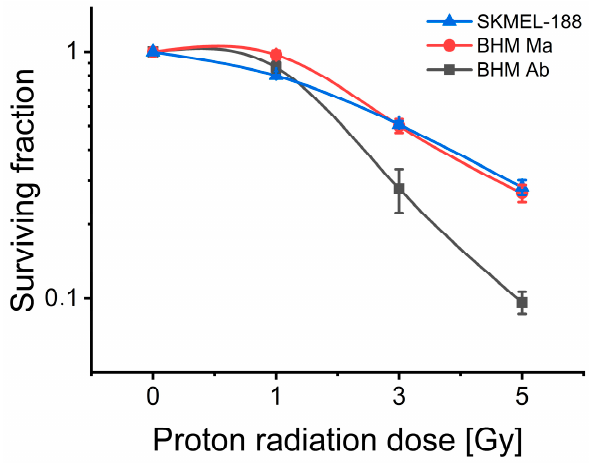
Figure 2. Proton beam radiosensitivity of SKMel-188, BHM Ma and BHM Ab melanoma cells. Surviving fraction was determined from the model described by Buch et al. [34], based on the experimental data from cell number, counted every 24 h for 4 days in culture after irradiation.